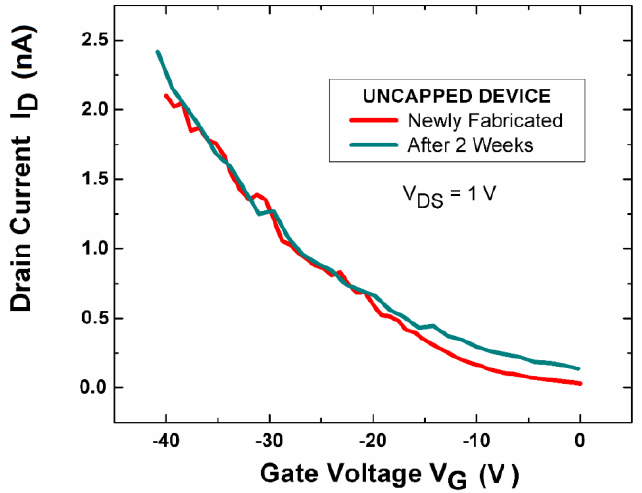
Figure 8. I DS - V G curve of uncapped InSe-based transistors freshly fabricated (red curve) and after two weeks (blue curve). Reproduced with permission from Ref. [20]. Copyright Royal Society of Chemistry, 2016.